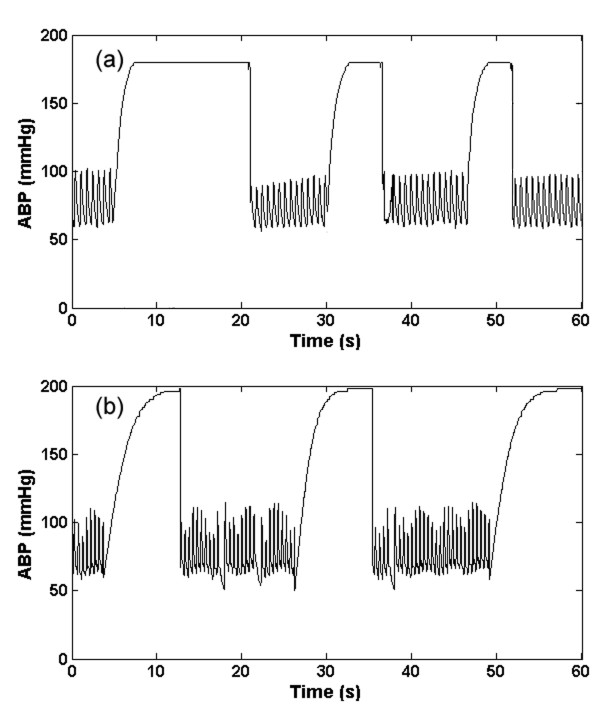
Artifact 1, (asmax); Real (a) and simulated (b) ABP saturation to maximum pressure, defined by Eq. (1).